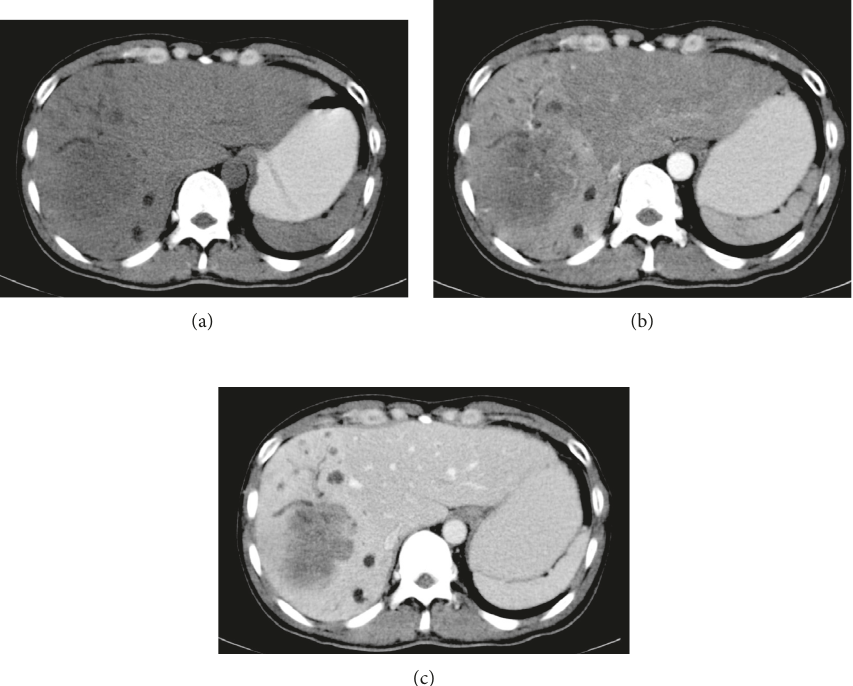
Figure 1: Computed tomographic scan showed tumor (a) hypoattenuating in precontrast phase, (b) no enhancement in arterial phase, and (c) mild enhancement in portal venous phase.